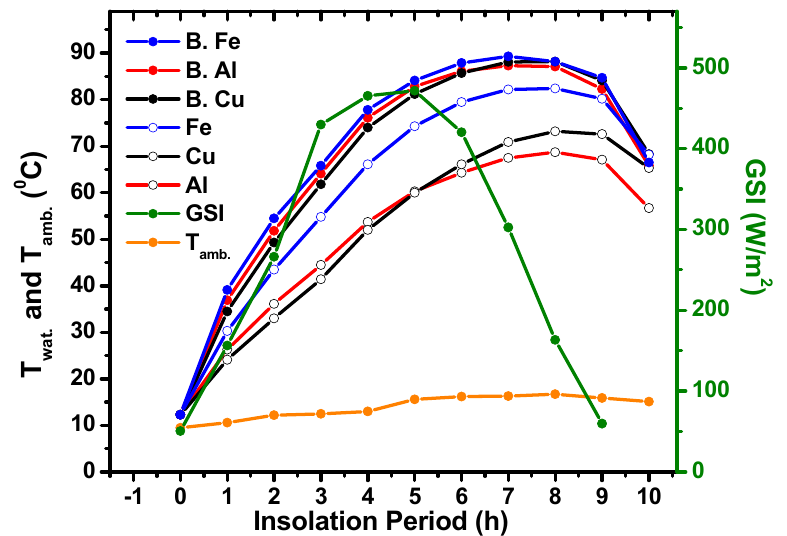
Figure 9. Water and ambient temperatures (T wat . and T amb .) and global solar intensity (GSI) against isolation period, six containers of 1 mm thickness; starting time: 7:00 a.m.; sunny day; date: 08/01/2022, Amman, Jordan.